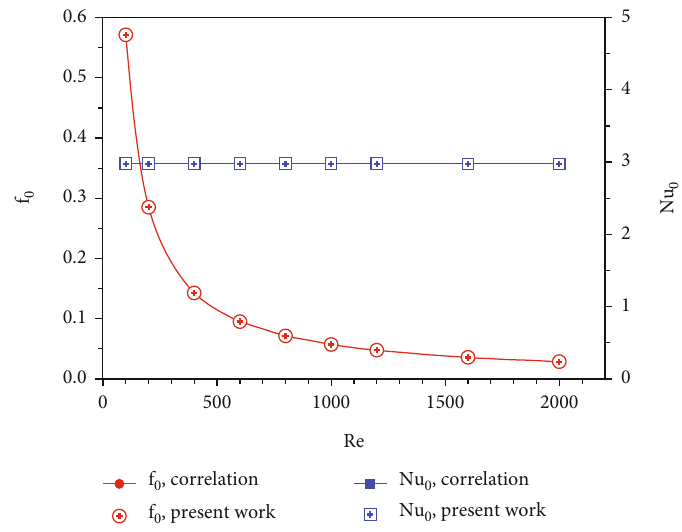
Figure 2: Validation of smooth square